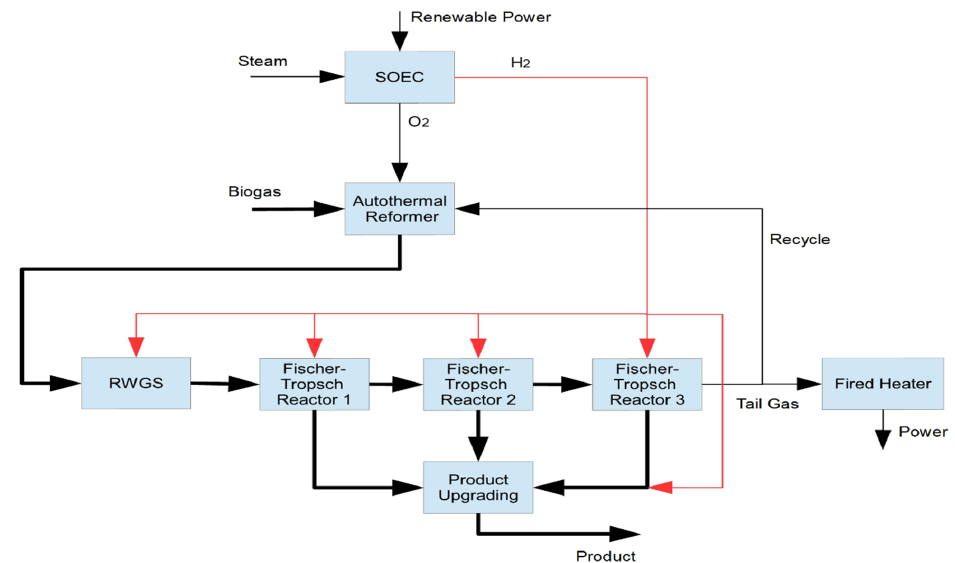
Figure 8. Block diagram of staged biogas-to-liquids production. Hydrogen generated by steam electrolysis is added to the process at high temperature (i.e., RWGS reactor) as well as at low temperature (i.e., FT reactors).